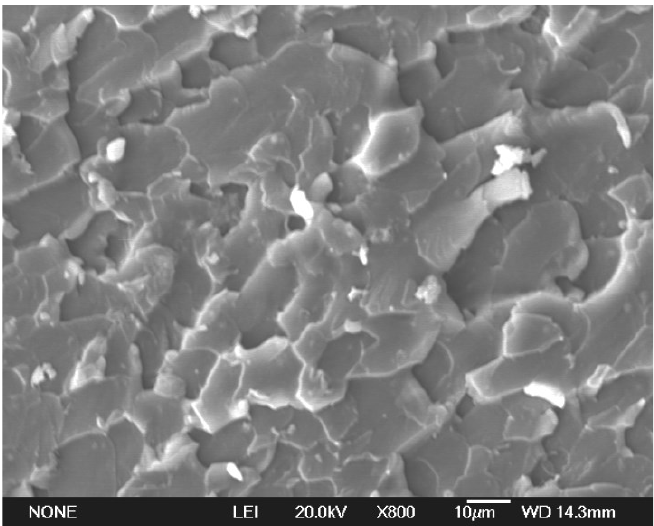
Figure 3. The stretch section of the composite with 6 wt.% aluminum